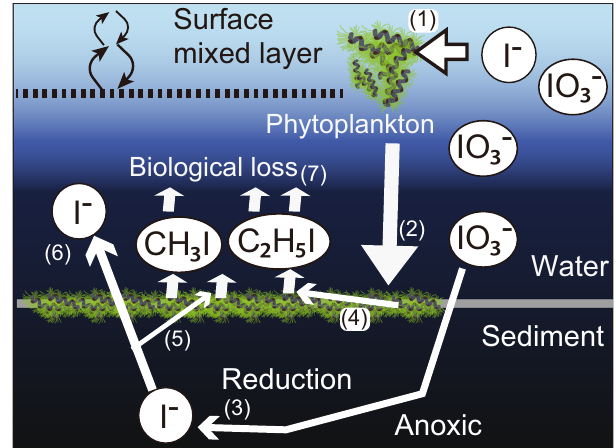
Fig. 5 Diagram of the iodine cycle between water column and sediment. Iodine cycle between water column and sediment is shown in relation to Fig. 4 Time series of VOIs amounts by dark incubation experiment.